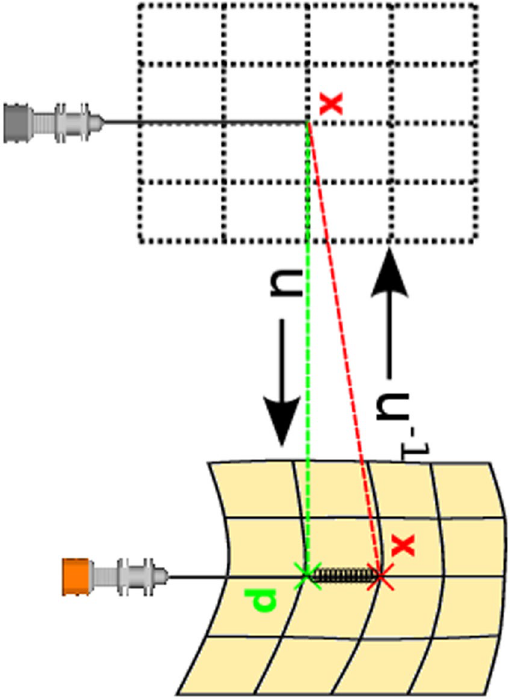
Figure 15. Needle in undeformed state of the virtual patient as defined by the proxy (left) and needle steered by the haptic device in the current deformed configuration of the tissue (right). Connecting x and p by a spring is used to calculate force